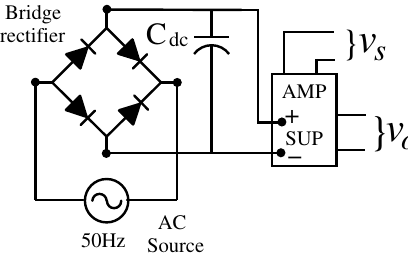
Figure 23. Disturbance rejection test setup.